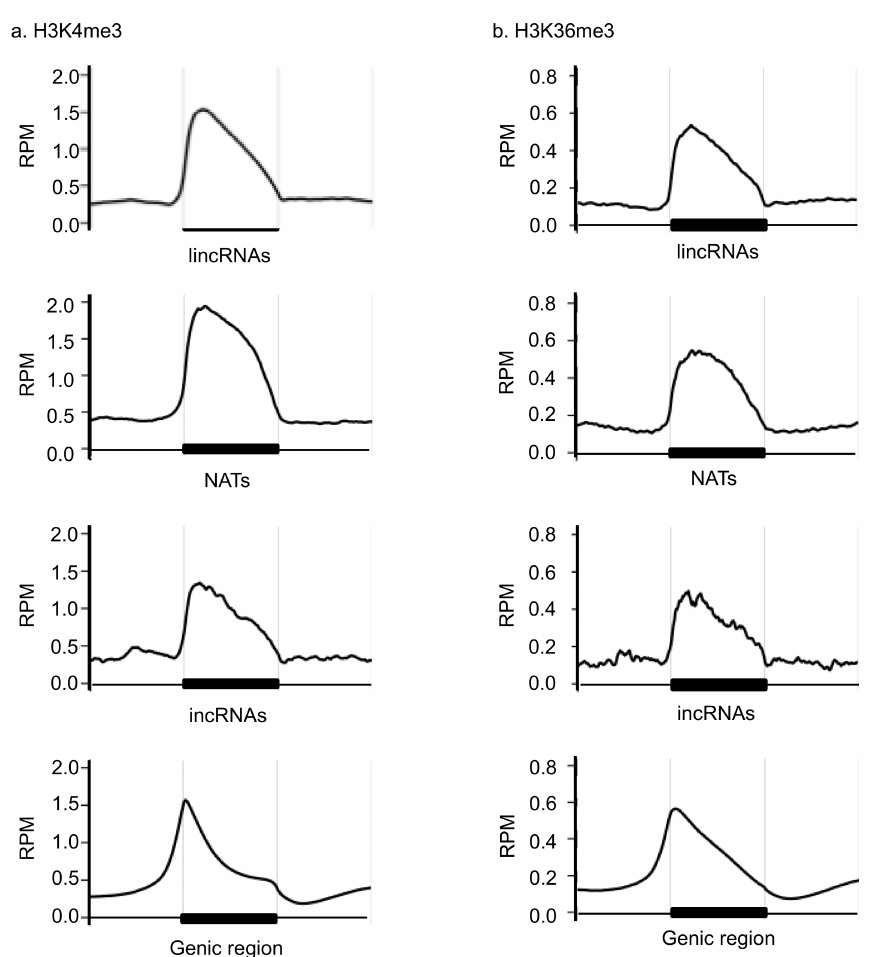
Figure 1. Enrichment of H3K4me3 ( a ) and H3K36me3 ( b ) in the lncRNAs and genic region. The X-axis represents the region including 1 kb upstream and 1 kb downstream. The Y-axis represents the reads per million (RPM).